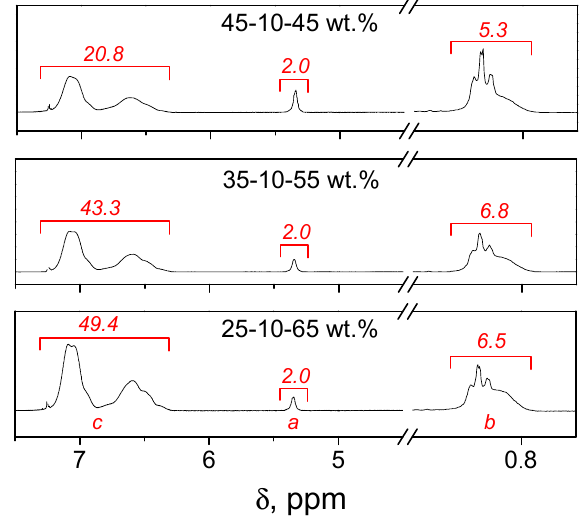
Figure 2. 1 H NMR spectra of terpolymers HOSBM-BA-St.